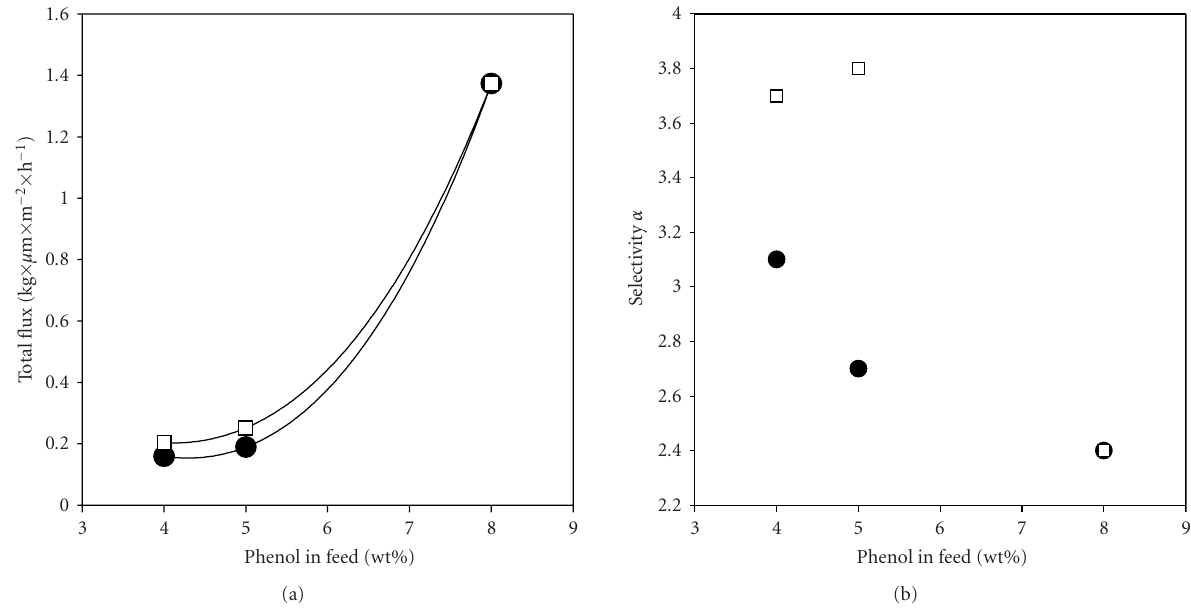
Figure 9: (a) Total flux in pervaporation experiments performed with increasing phenol concentration in feed ( • ) as well as decreasing phenol concentration ( (cid:3) ) and (b) separation factor with increasing phenol concentration in the feed mixture ( • ) as well as decreasing phenol concentration ( (cid:3) ) for the E-MAA 38 at 313 K and a permeate pressure of 15–30 mbar.